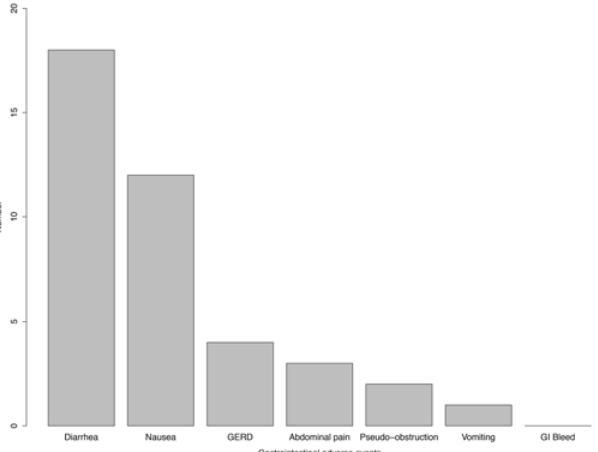
Fig 3. Bar graph illustrating gastrointestinal adverse events in SSc patients treated with mycophenolate.